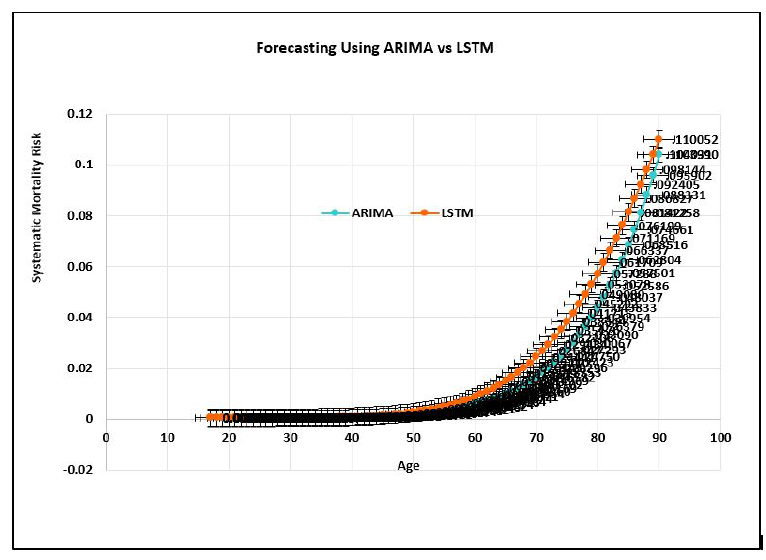
Figure 3. Systematic Mortality Risk Prediction Under ARIMA vs.